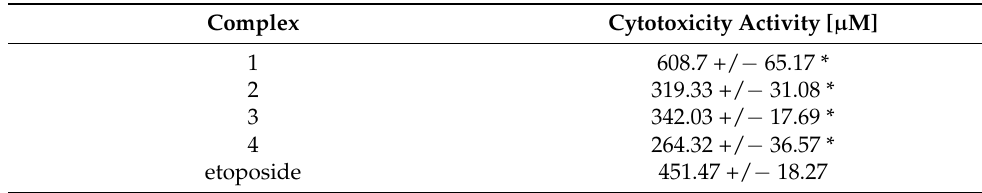
Table 1. Cytotoxicity activity with the IC 50 values. Statistical significance was assessed using one-way ANOVA analysis was performed.